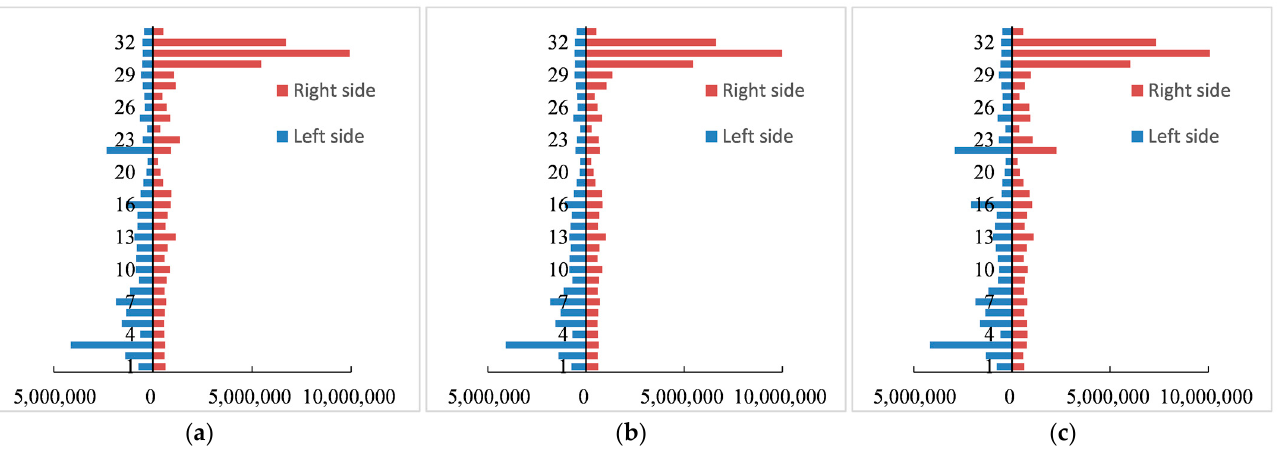
Figure 6. AEV of different buffers on the left and right sides along the QTR.